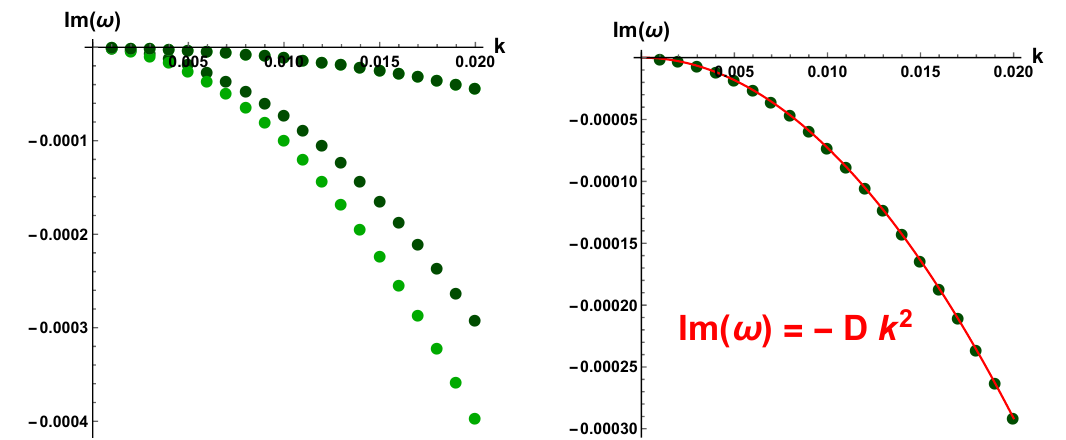
Figure 11: One example of the imaginary part of the QNMs spectrum ( left ) and the fitting done to extract the diffusion constant D from a diffusive mode ( right